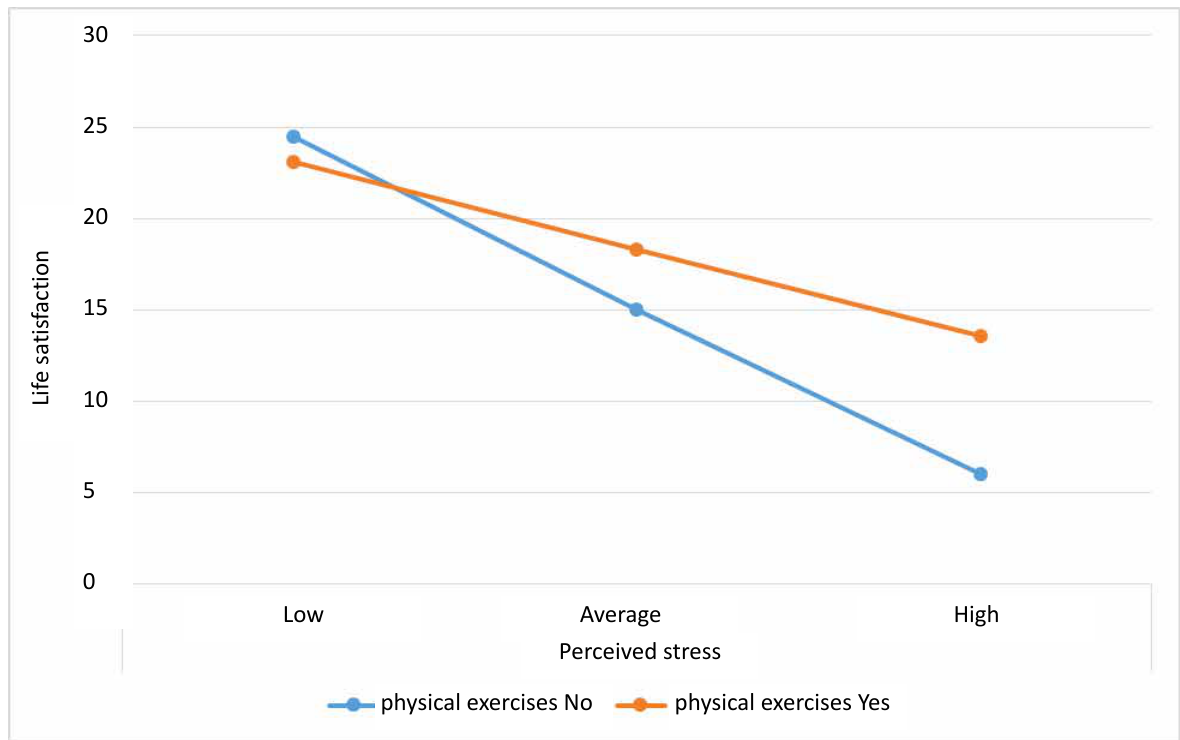
Fig. 1. Regression of satisfaction with life on physical exercises at three levels of perceived stress.